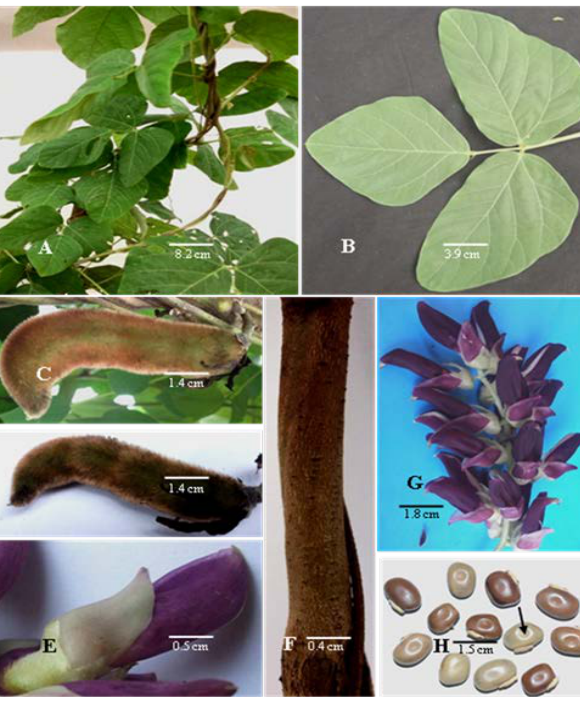
Fig. 3. Morphology of Desmodium adscendens (Sw.) DC. A. Habit (herbaceous creeper), B. Leaf, C. Stem, D. Stem rooting at node, E. Inflorescence, F - G. Flowers, H. Fruits, I. Seeds (fresh and dry), J. Fruits (showing hairs)